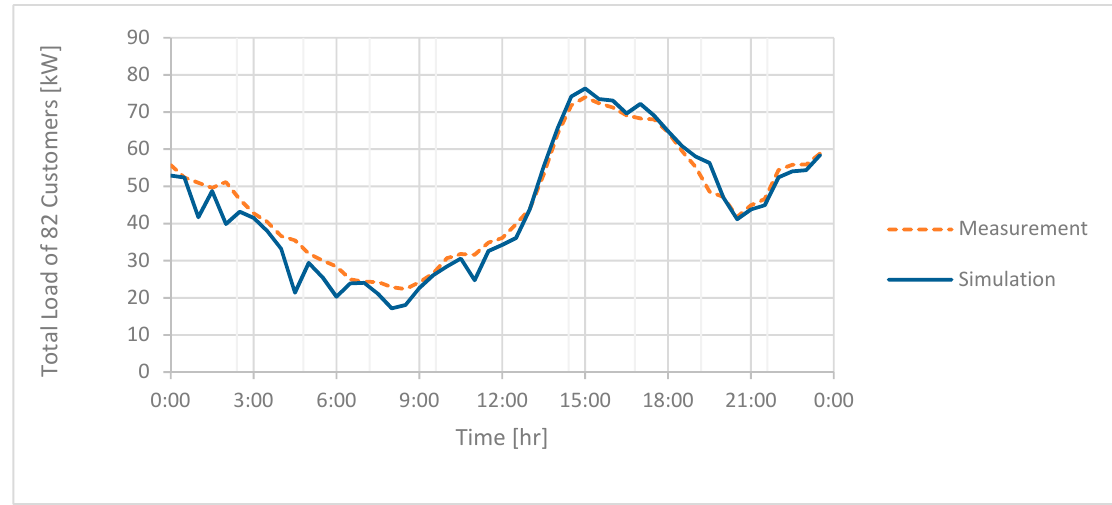
Figure 9. Comparison of load profile measurement results and simulation results.